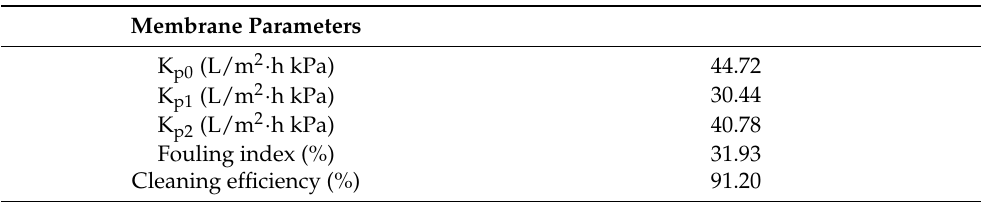
Table 2. Hydraulic permeabilities, cleaning efficiency, and fouling index of the MF membrane on processing of orange pricky pear